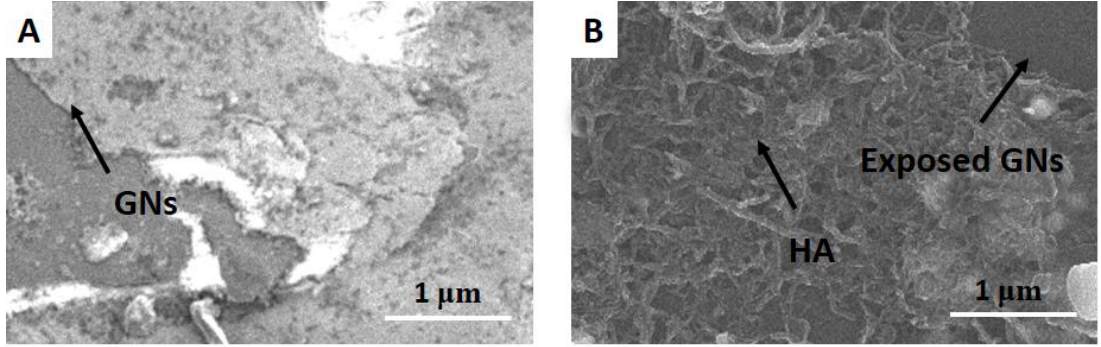
Figure 1. SEM images of graphene nanosheets (GNs) ( A ) and GNs/hydroxyapatite (HA) ( B ) on Si substrate.